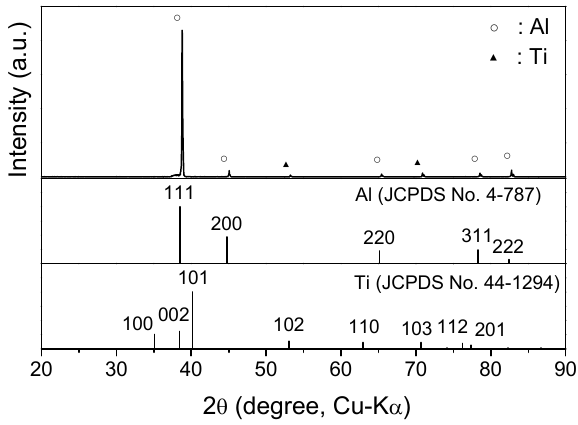
Figure 3. XRD pattern of electrodeposited Al layer on Ti substrate.